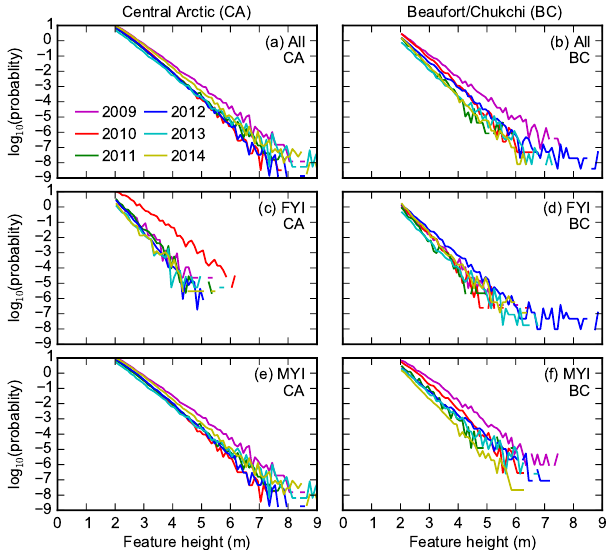
Figure 7. As in Fig. 6 but for the surface feature height, h f , prob- ability distribution plotted on a log (base 10) scale. Only features higher than 2m are shown to focus on the tail of the probability distributions.